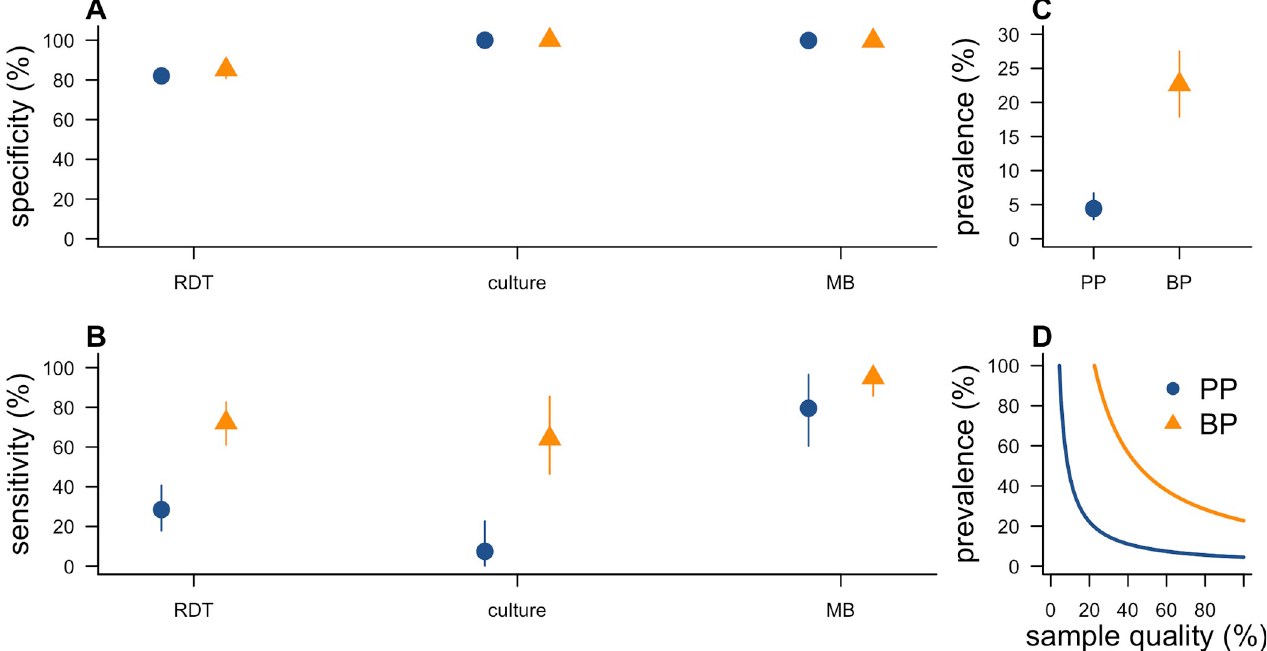
Fig 3. Model estimates of test performance and prevalence. (A) Specificity of each test, with RDT denoting rapid diagnostic test and MB denoting molecular biology. (B) Sensitivity of each test. (C) Prevalence of Y . pestis infection among notified cases, under the assumption of perfect sample quality. (D) Relationship between sample quality (i.e., the proportion of samples from infected individuals that contain detectable bacterial material) and estimated prevalence of infection among notified cases. Results are presented by clinical form: pneumonic (PP: blue) and bubonic (BP: orange). The circle/triangle shows the posterior median of the parameter while the lines show the 95% credible interval. The underlying data and code to reproduce this figure are available on Open Science Framework (https://osf.io/nbc4t/). BP, bubonic plague; MB, molecular biology; PP, pneumonic plague; RDT, rapid diagnostic test.